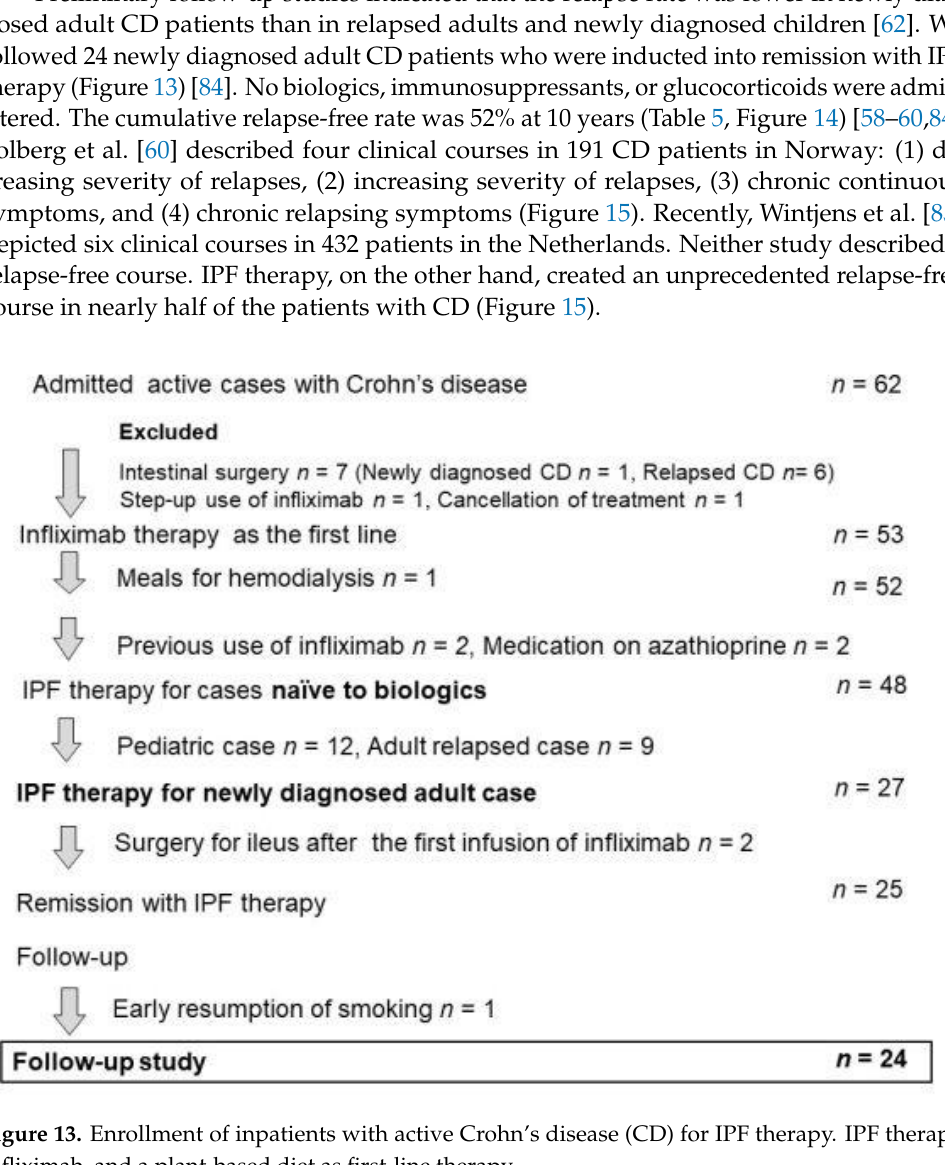
Figure 13. Enrollment of inpatients with active Crohn’s disease (CD) for IPF therapy. IPF therapy, infliximab, and a plant-based diet as first-line therapy.